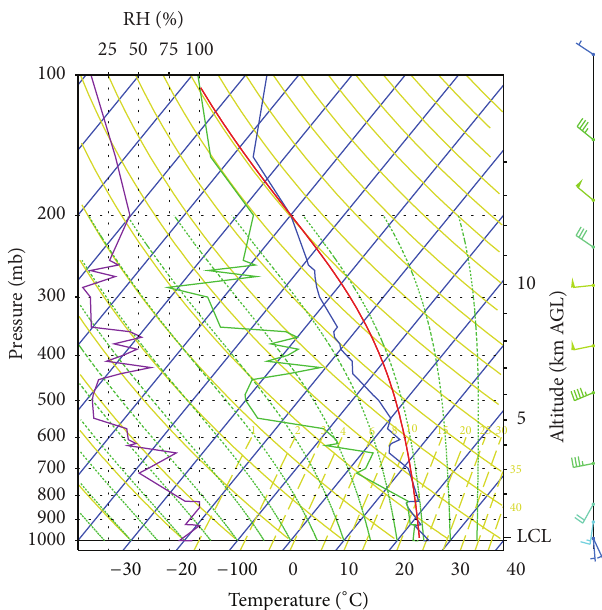
Figure 3: Skew T-lnP diagram of Hong Kong sounding released at 0800 LST 24 April 2007. Each half barb indicates 5 knots; each full barb,10knots;andeachflag,50knots(1knot=0.514 m/s).Thelifting condensation level (LCL) is indicated. The relative humidity is given in the left panel.